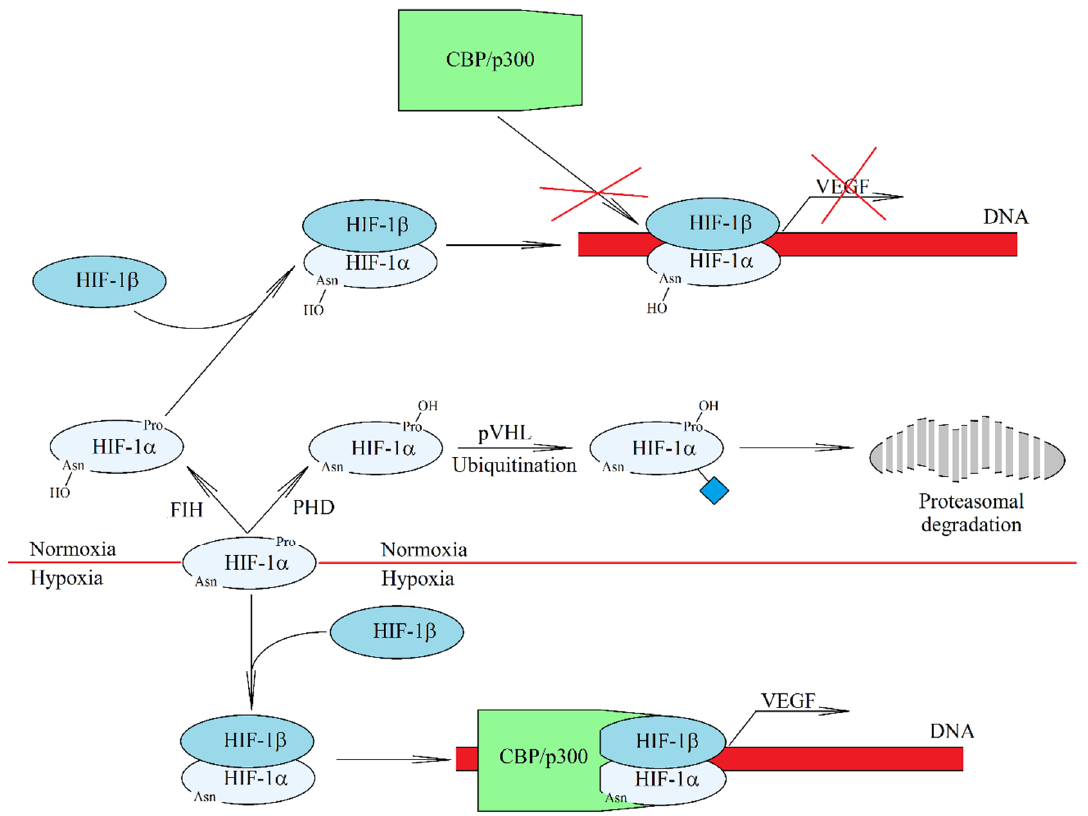
Figure 2. HIF-1 activation mechanism in hypoxia. In normoxia, HIF-1 α is hydroxylated by oxygen-dependent enzymes. Hydroxylation by hypoxia-inducible factor (FIH) prevents the interaction between HIF-1 α and CBP / p300 transcriptional coactivator. In turn, hydroxylation by prolyl hydroxylase domain (PHD) leads to the ubiquitination of HIF-1 α and then proteasomal degradation of this HIF-1 subunit. As a result no HIF-1 is formed. Hypoxia, on the other hand, induces an increase in the level of HIF-1 α , which is no longer hydroxylated by either FIH or PHD. A functional HIF-1 complex is formed and transferred to the cell nucleus from where it is responsible for the transcription of genes induced by hypoxia.